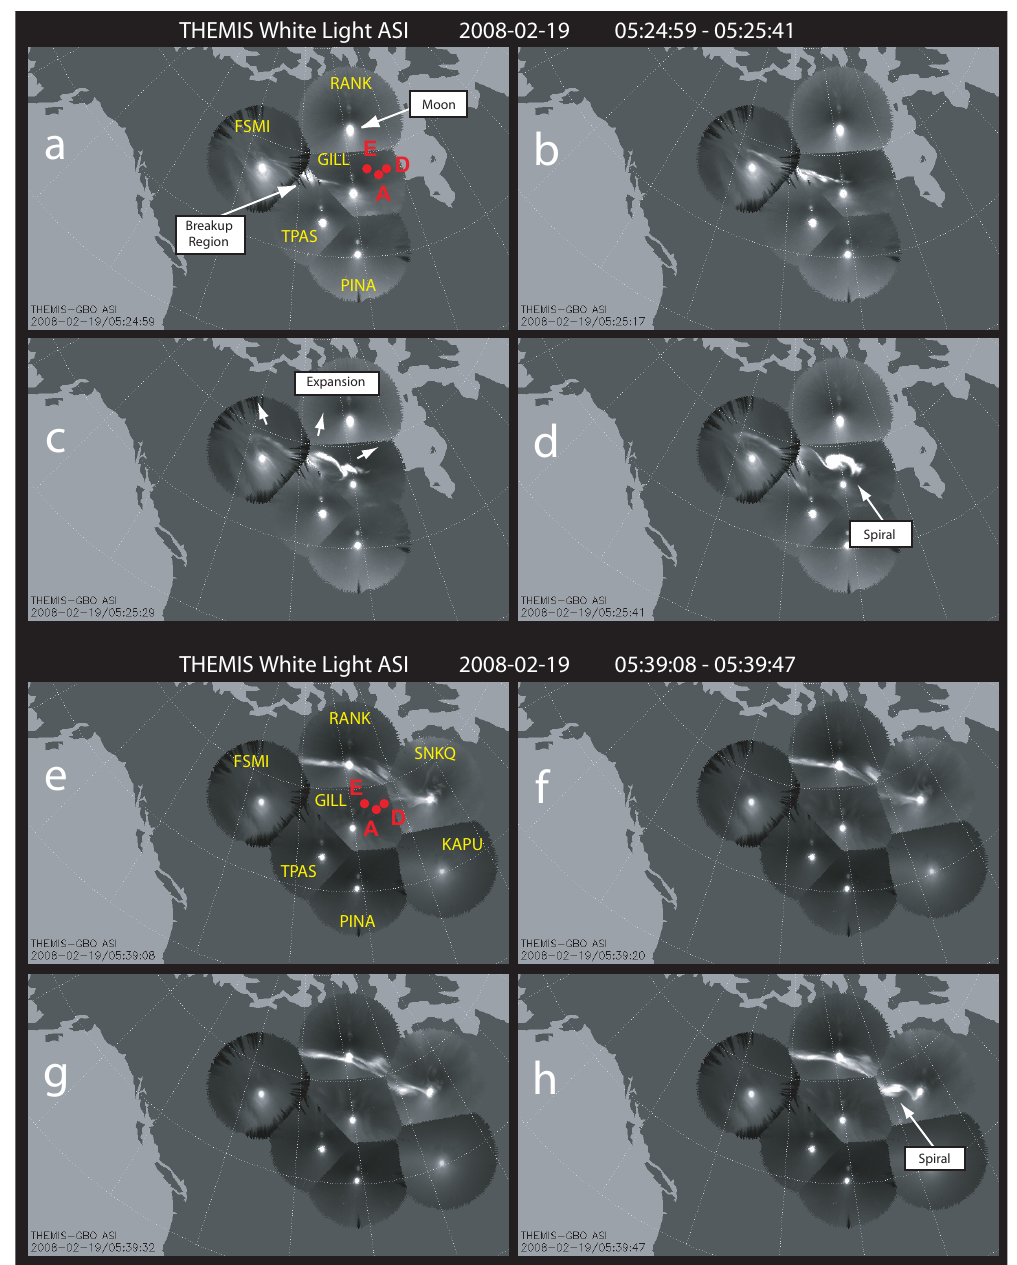
Fig. 2. (a–d) A sequence of ASI images showing the formation of the first auroral spiral on 19 February 2008. Red circles are the footprints of the THEMIS spacecraft as derived from T96. (e–h) A sequence of ASI images showing the formation of the second auroral spiral, approximately 14min later. The bright spot in each ASI image is the